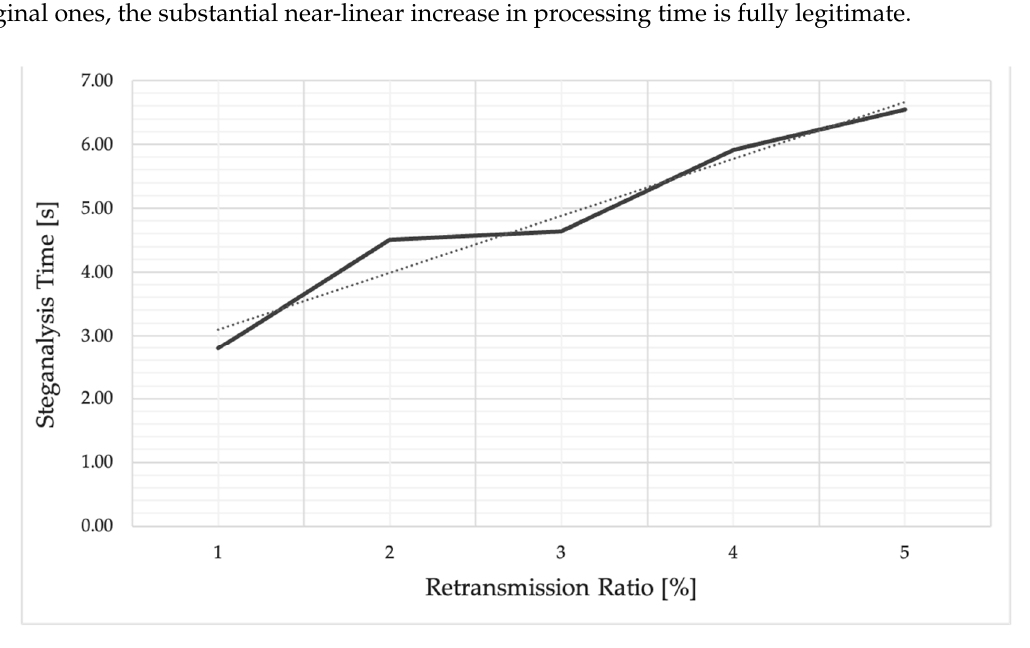
Figure 7. Raw Data Steganalysis time.